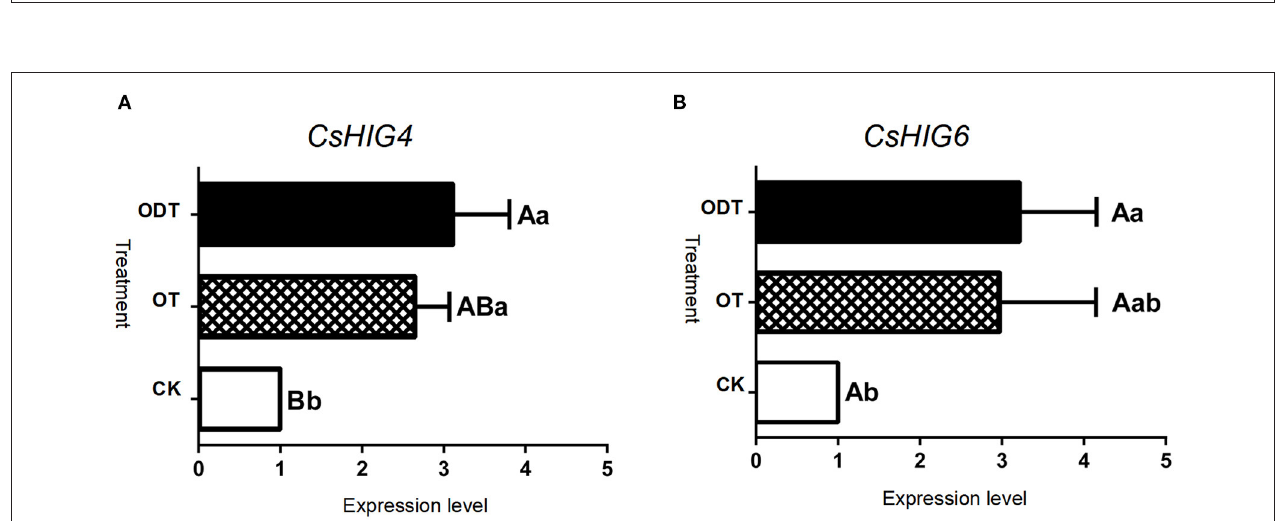
FIGURE 9 | Relative expression level of key CsHIG gene transcripts under normoxic and hypoxic conditions during the turnover process of oolong tea. FPKM values and expression levels of (A) CsHIG4 and (B) CsHIG6 . F (control group) represents fresh tea leaves without any treatment. ODT (oxygen-deficient leaves) represents fresh tea leaves turned over under hypoxic conditions. OT (normal leaves) represents fresh tea leaves turned over under normoxic conditions. Different uppercase letters ( P < 0.01) and lowercase letters ( P < 0.05) indicate significant differences among different treatments from Tukey’s test. Error bars indicate the standard error (SE) of the